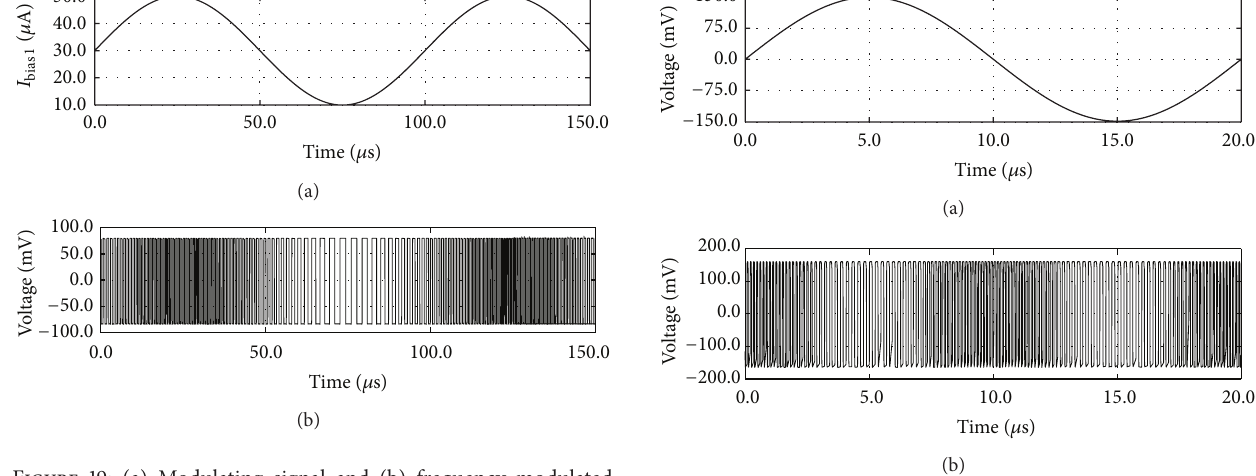
Figure 19: (a) Modulating signal and (b) frequency modulated signal.